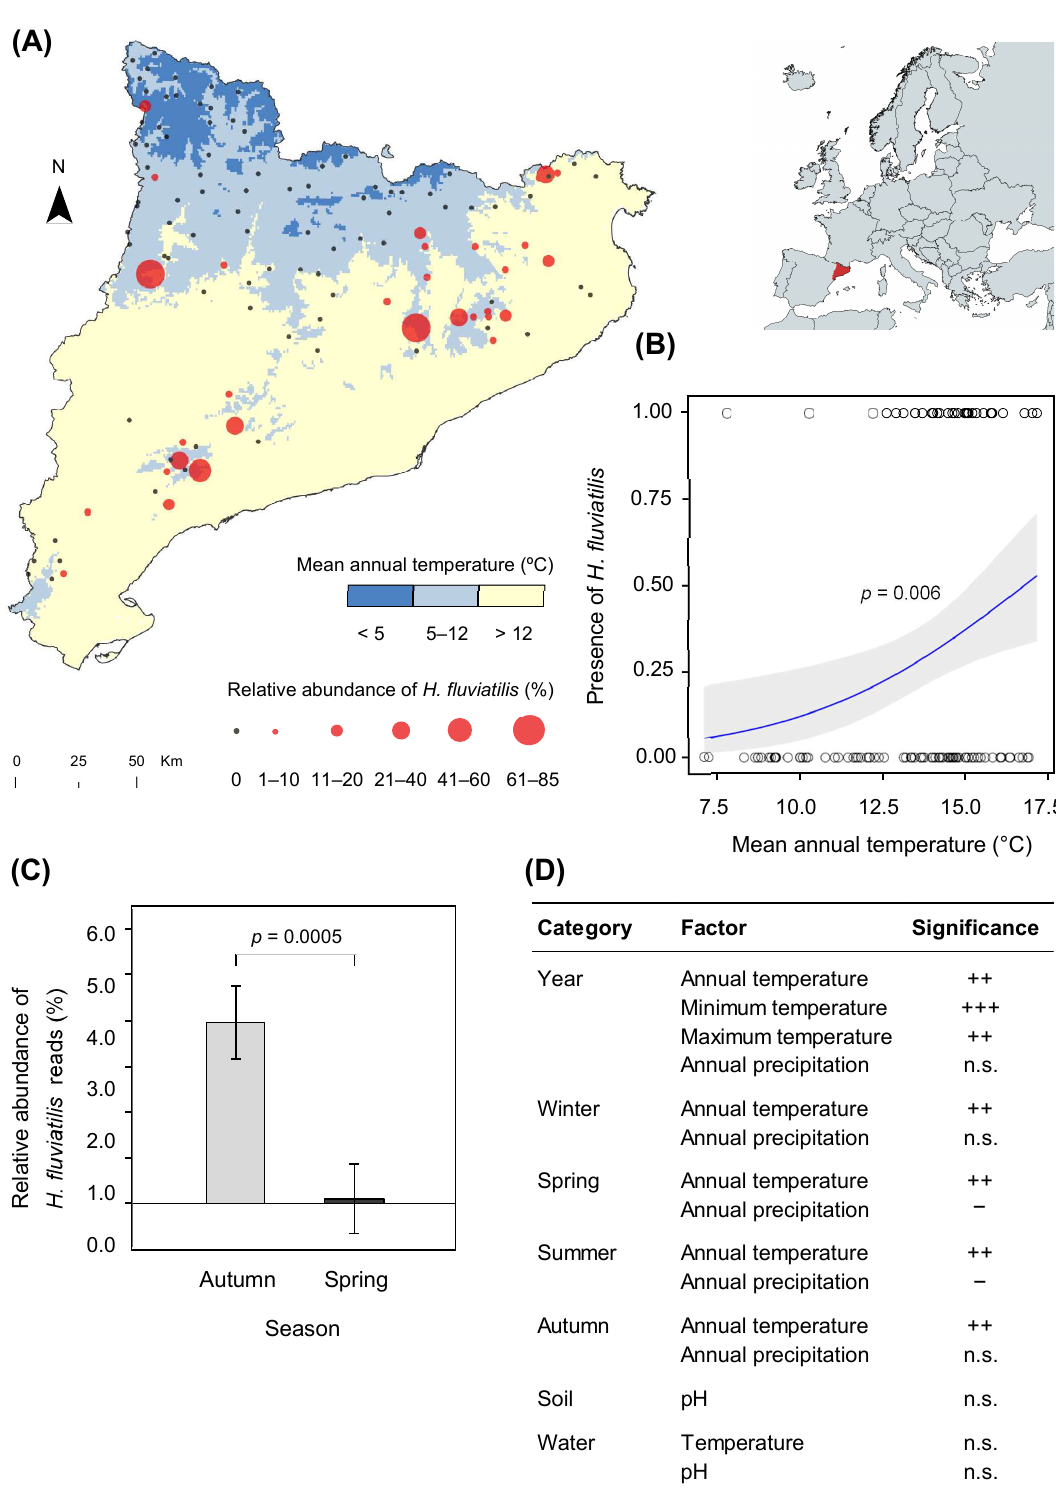
Figure 1. Distribution of Halophytophthora fluviatilis in Catalonia (NE Spain) ( A ), and association with mean annual temperature following a logistic regression model for H. fluviatilis presence or absence ( B ). Mean relative abundance of reads per sample in autumn and in spring. Error bars represent SE. ( C ). Correlation between presence of H. fluviatilis and climatic variables where “+++”and “++” indicate significant positive associations at p < 0.001 and p < 0.01, respectively (“ − “ sign is used for negative associations at p < 0.05) ( D